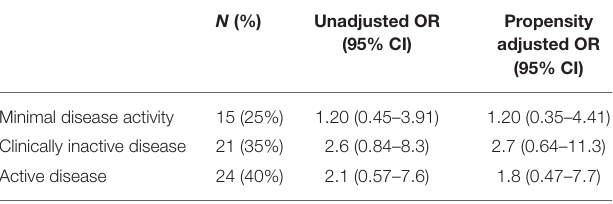
TABLE 3 | Primary outcomes after 1 year of Tocilizumab therapy.